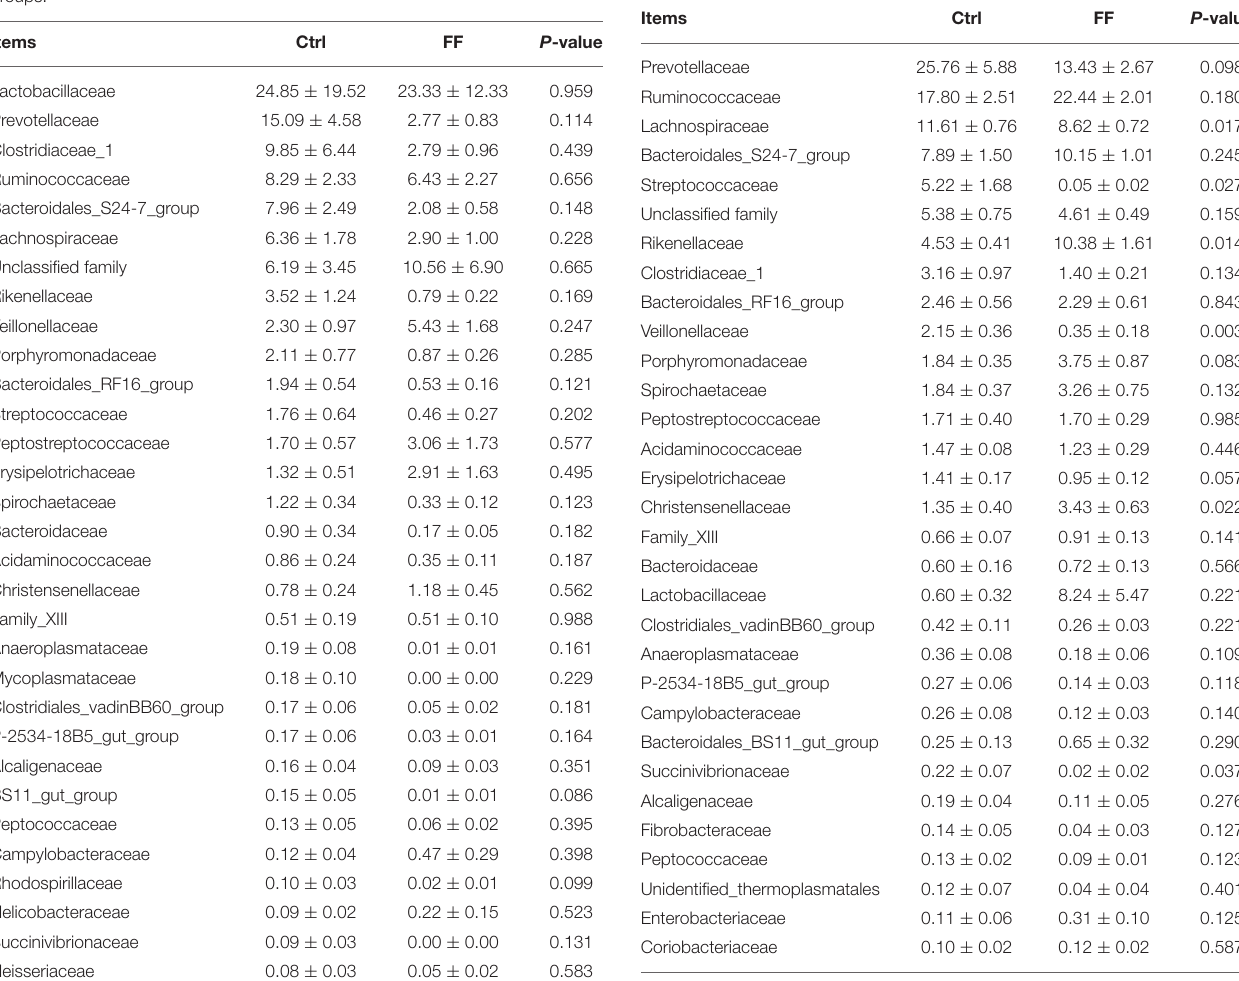
TABLE 4 | Relative abundance (percentage) for the top 30 most abundant family in the duodenal mucosa-associated microbiota of pigs in the FF and control groups.